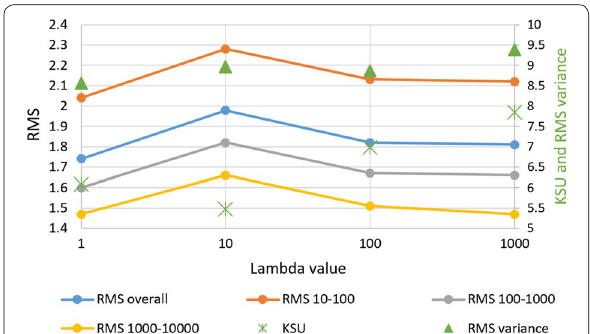
Fig. 2 Summary of overall RMS, and RMS per period decade, for models testing the initial (cid:31) for 1000, 100, 10 and 1. The number of KSU used for each inversion and the RMS var are also displayed with values on the right vertical